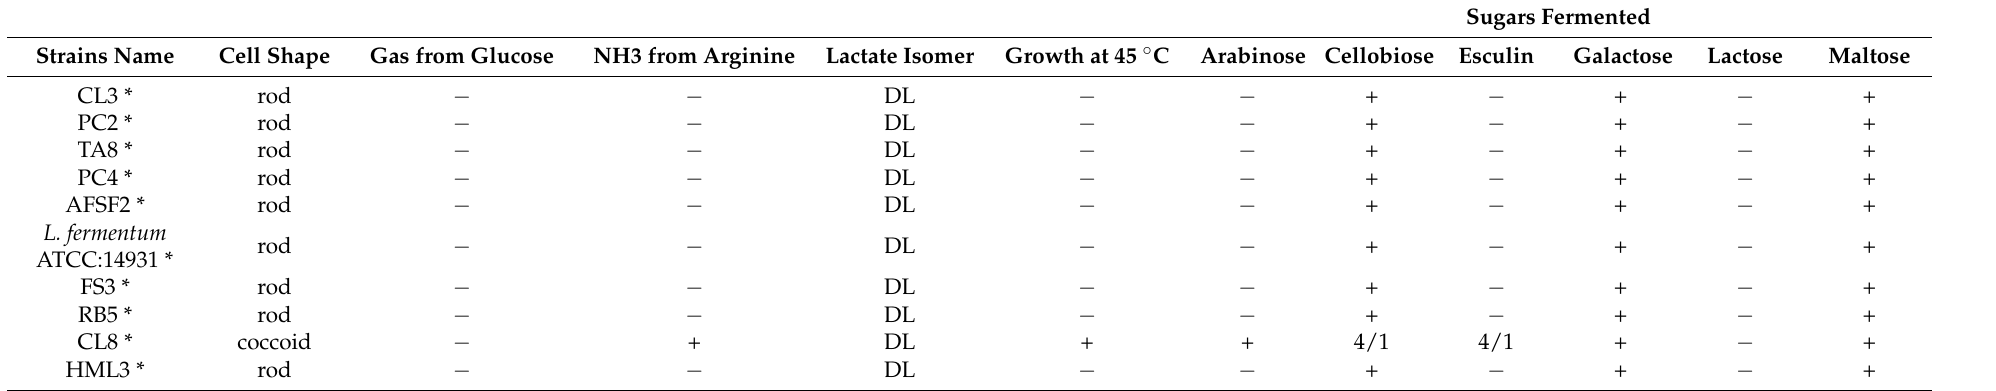
Table 3. API 50CHL kit identification of the ten LABs with their characterizations and fermentable